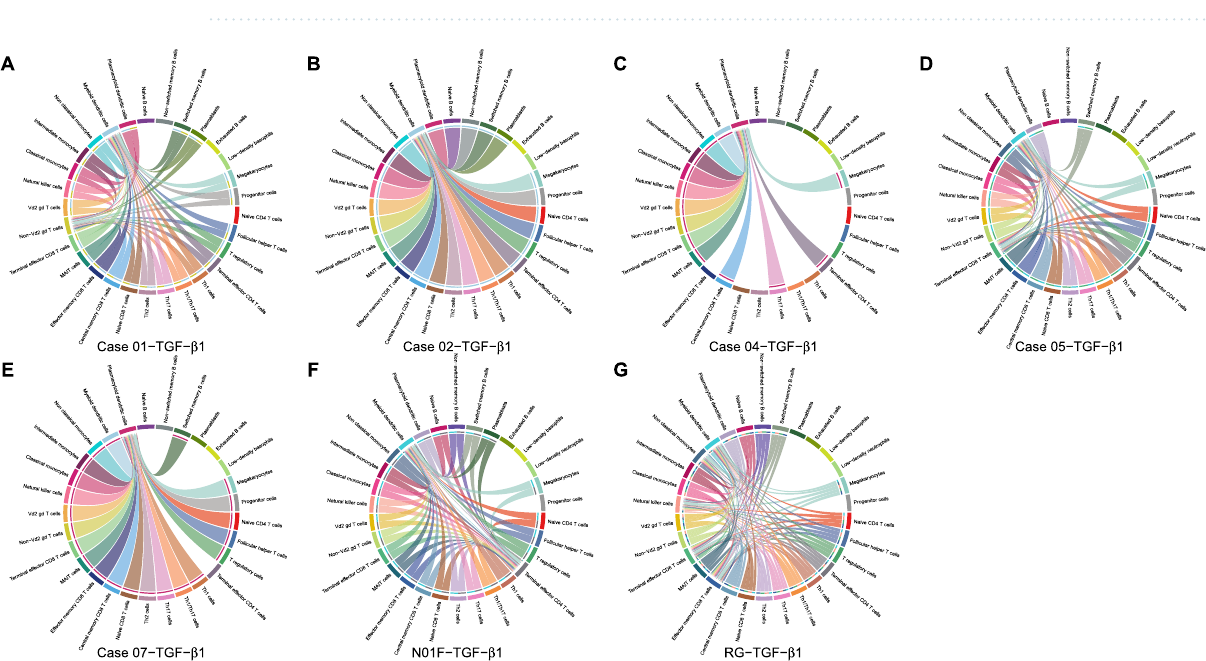
Figure 6. Cell–cell interaction signaling of TGF-β1. ( A – G ) TGF-β1 signaling for Cases 01, 02, 04, 05, 07, health control N01F, and RG. Arrows from source cells to target cells indicate inferred signaling ligand secretion and